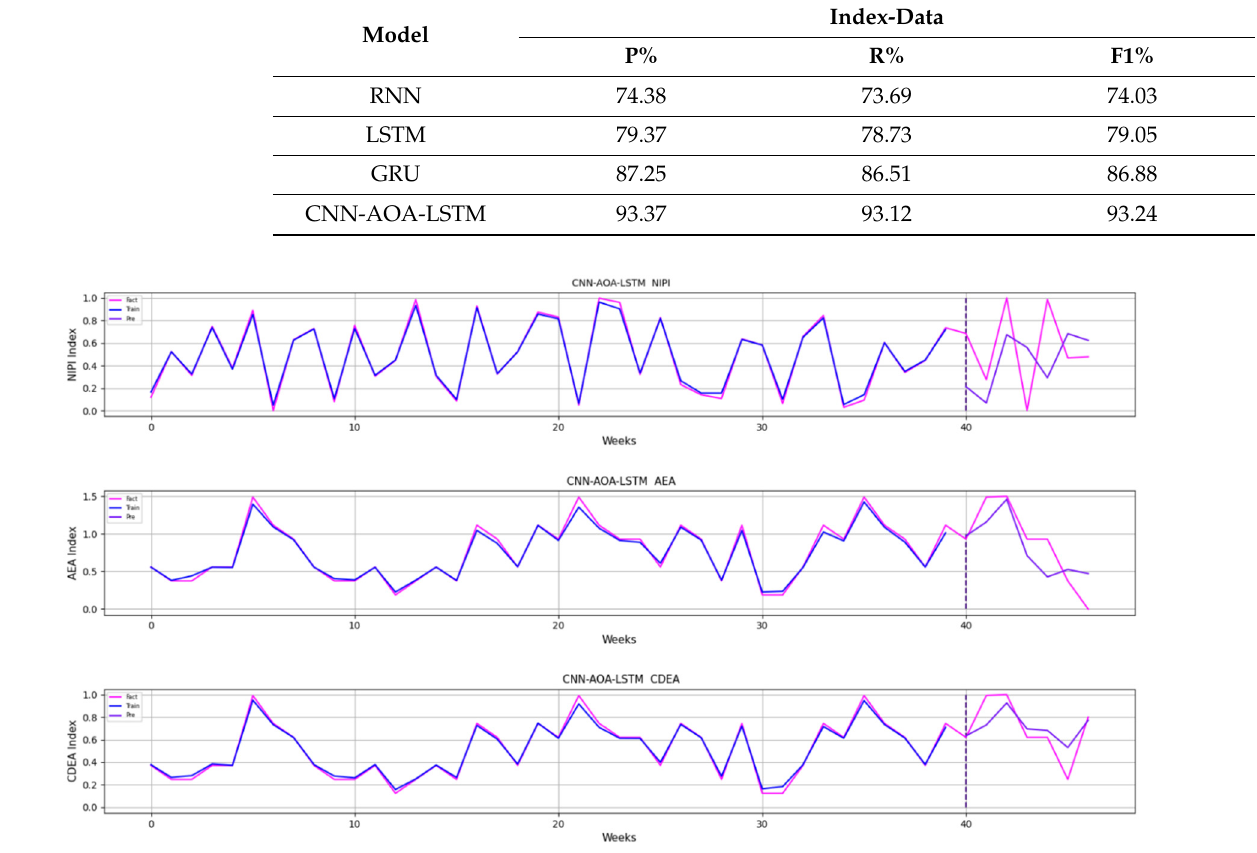
Figure 18. Random sample analysis of predicted results.